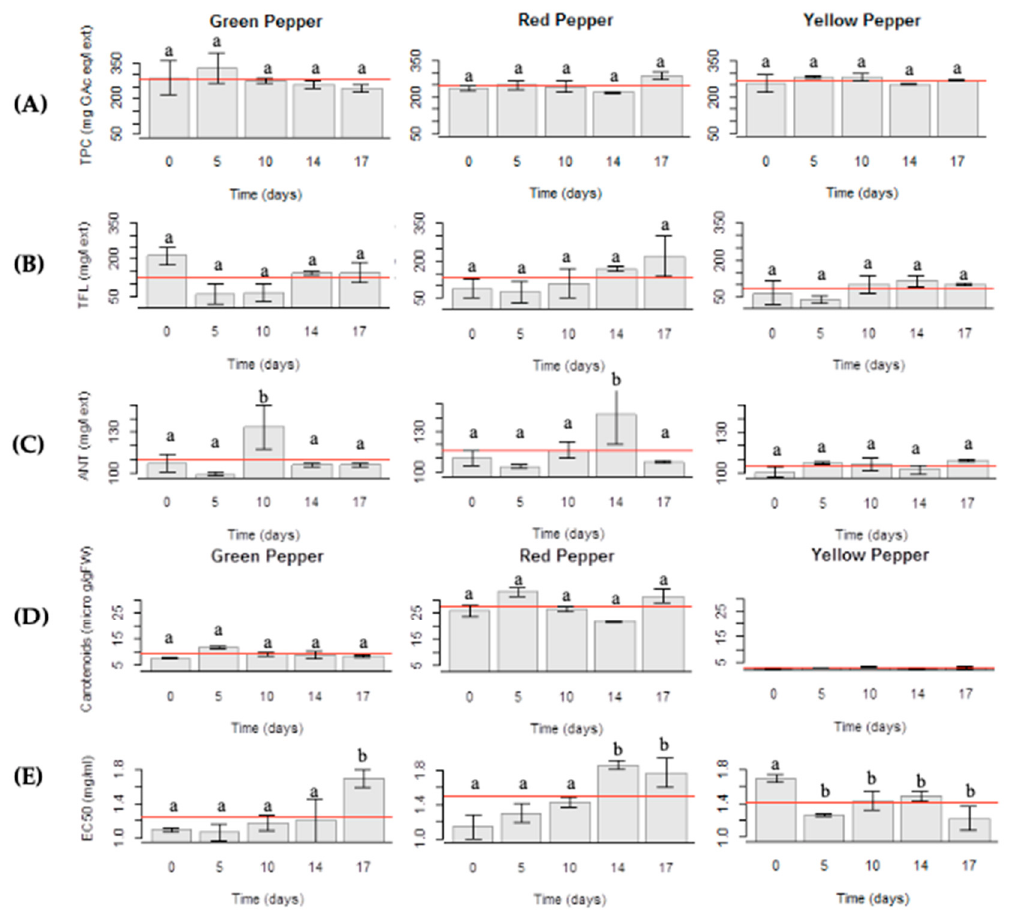
Figure 4. ( A ) Total phenol content (TPC); ( B ) Total flavonoid content (TFL); ( C ) Total anthocyanin content (ANT); ( D ) Total carotenoid content and ( E ) Antioxidant activity (EC 50 ) in fresh-cut bell peppers (green pepper; red pepper; yellow pepper) stored under an initial MAP condition of 10% O 2 and 45% CO 2 throughout 17 days at 5 °C. a—no significant differences ( p > 0.05); b—significant differences ( p < 0.05). The horizontal line represents the statistical mean.